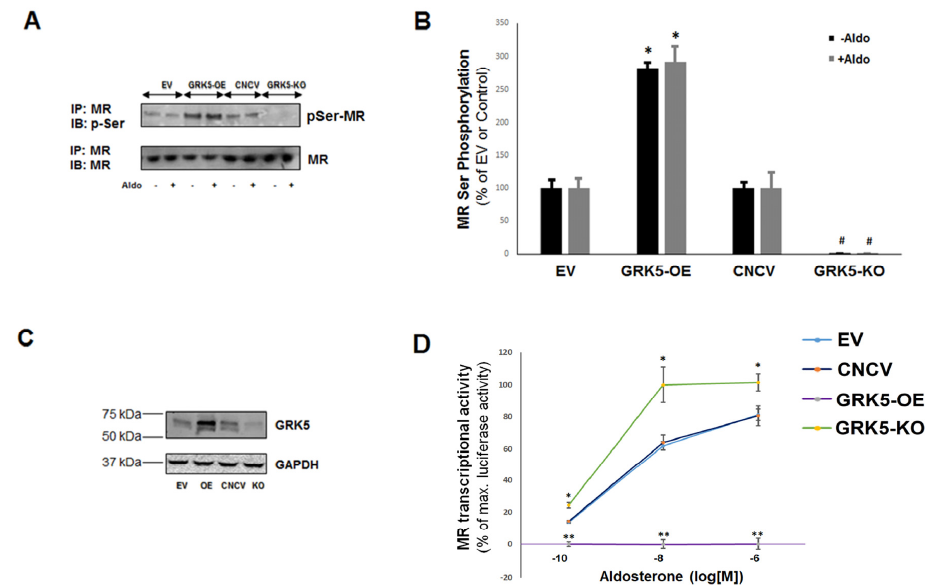
Figure 3. GRK5 phosphorylates and inhibits the MR in cardiac myocytes. ( A ) Western blotting